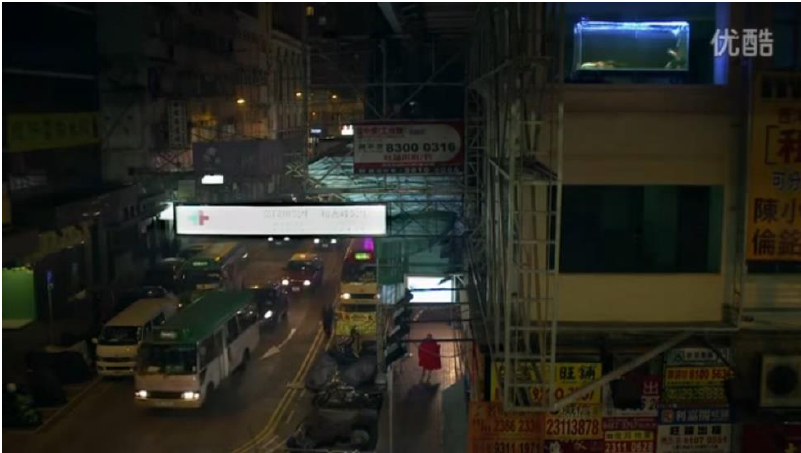
Figure 5. A high angle extreme long shot of the walker, half-hidden by scaffolding.